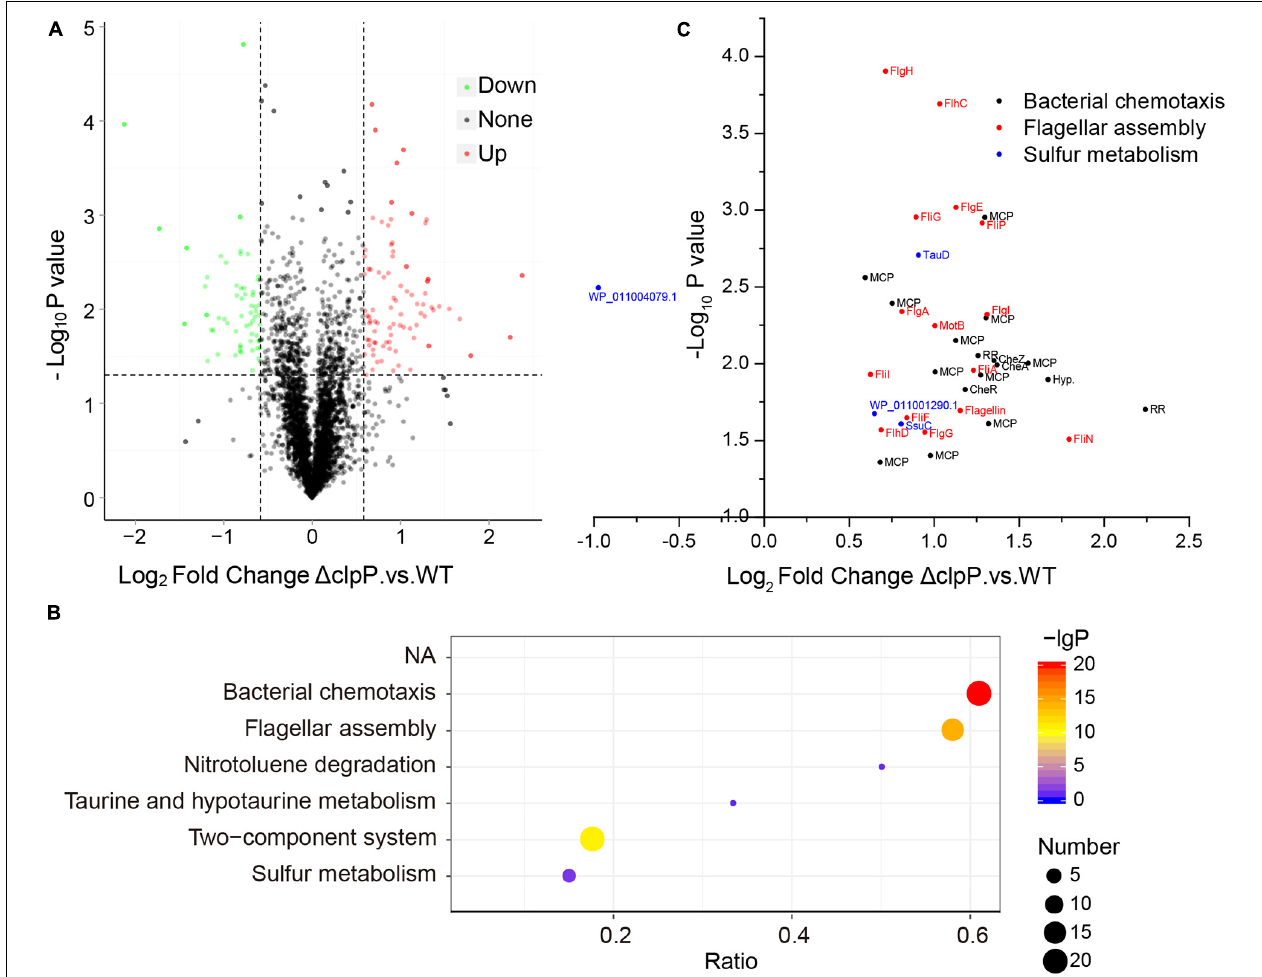
FIGURE 3 | Possible substrates of ClpP identified by iTRAQ (isobaric tags for relative and absolute quantitation). (A) Relative expression of proteins identified in (cid:49) clpP compared with the wild-type (WT) strain GMI1000. The proteins with > 1.5-fold expression difference between (cid:49) clpP and WT and with P < 0.05 were defined as differentially expressed proteins. (B) Kyoto Encyclopedia of Genes and Genomes (KEGG) enrichment of differentially expressed proteins of (cid:49) clpP versus WT. The number of differentially expressed proteins is indicated by the size of the bubbles. P -values of enrichment are indicated by the color of bubbles. The ratio represents the number of proteins identified in this pathway divided by the number of differentially expressed proteins mapped to this pathway. The top six over enriched KEGG pathways were shown. (C) Relative expression of differentially expressed proteins mapped to bacterial chemotaxis, flagellar assembly, and sulfur metabolism